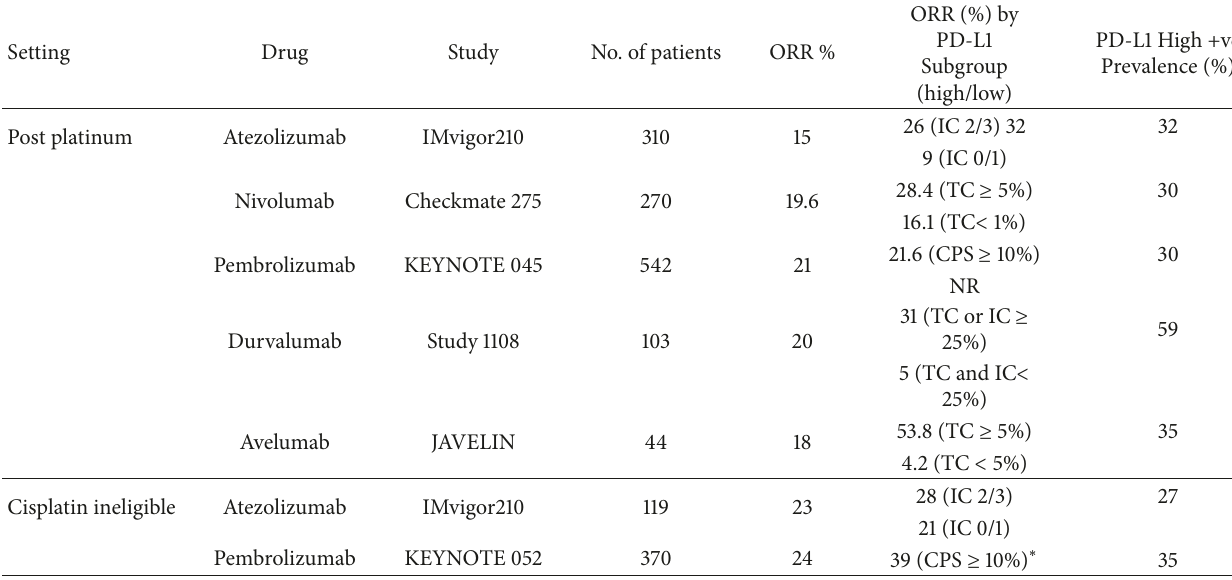
Table 2: Immunotherapy trials